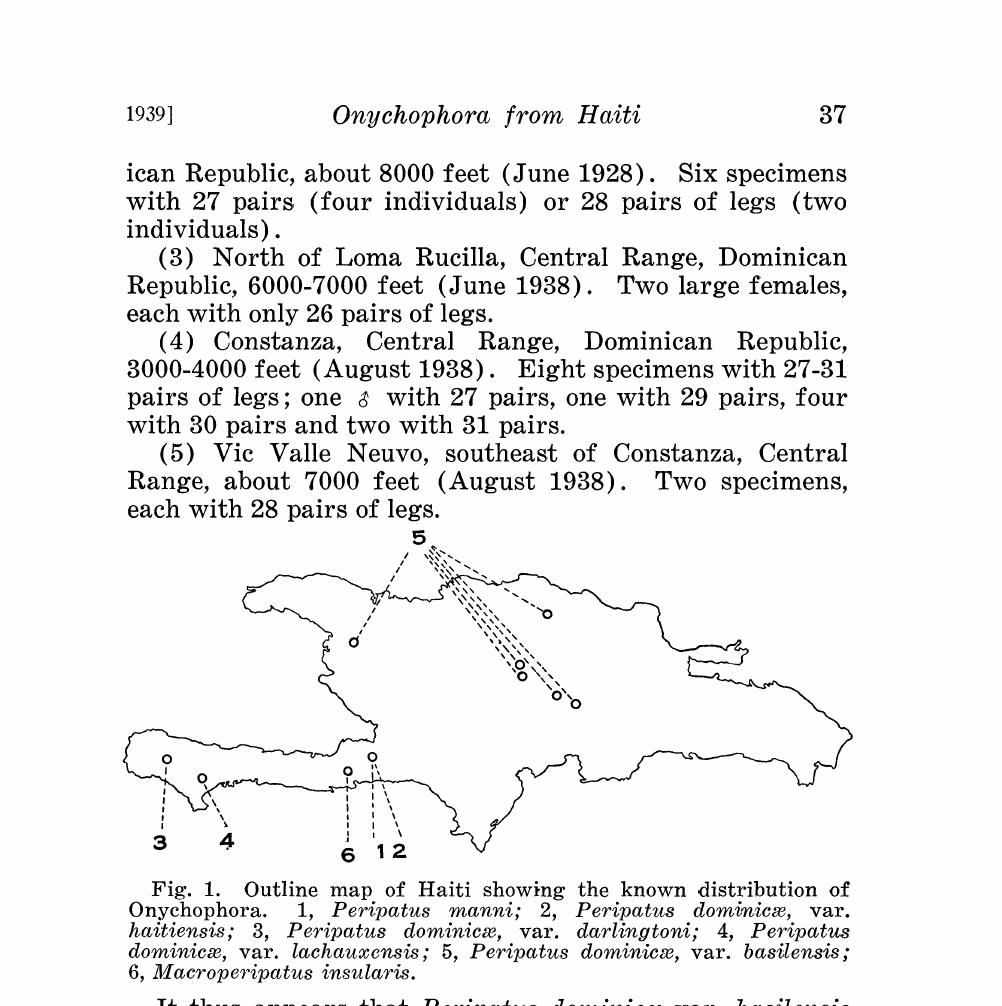
Fig. 1. Outline map o Haiti showing the known distribution o Onychophora. 1, Peripatus manni; 2, Peripatus domiicx, var. haitiensis; 3, Peripatus dominicx, var. darlingtoni; 4, Peripatus dominicx, var. lachauxcnsis; 5, Peripatus domi.nicx, var. basilensis; 6, Macroperipatus